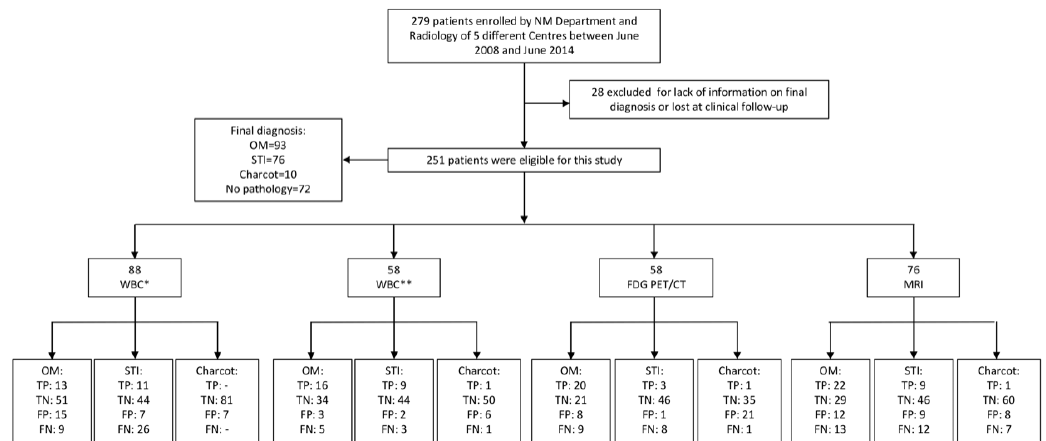
Scheme 1. Flow chart on patient selection and imaging modalities. NM: Nuclear Medicine; OM: osteomyelitis; STI: soft tissue infection; WBC: white blood cells scintigraphy; * WBC scans acquired without